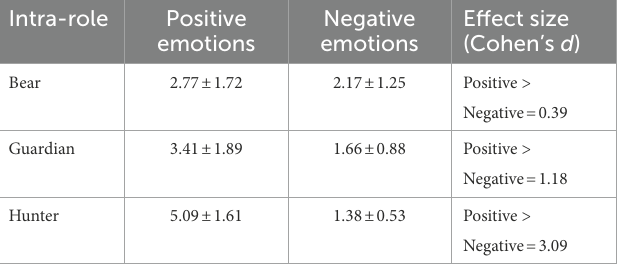
TABLE 1 Positive and negative emotions (mean, standard deviation, and effect sizes) by